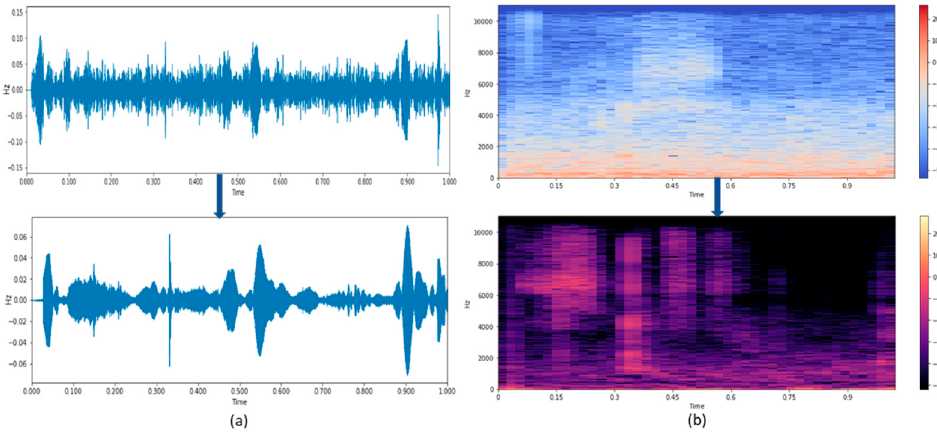
Figure 7. ( a , b ) Time waveform and Spectrogram of speech signal using ISE. Figure 7b represents the spectrogram of a signal that has been enhanced using the ISE. It is visible that there is an enhancement in the noise corrupted speech while using